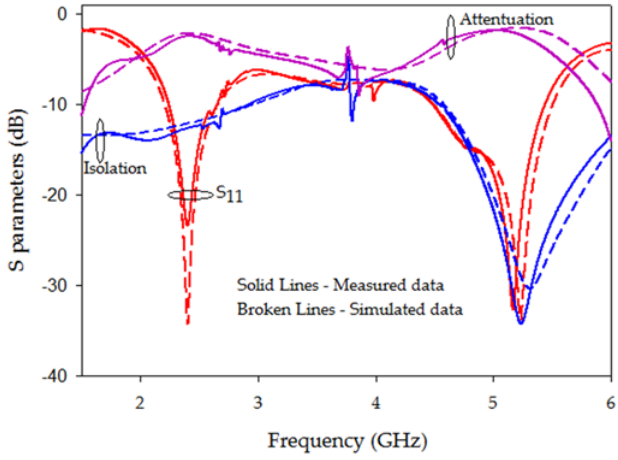
Figure 8. Variation of S parameters with frequency for DPC.